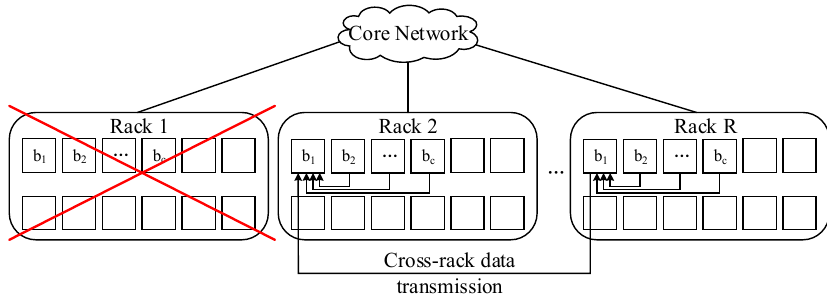
Figure 5. Data transmission during reconstruction after single rack failure.